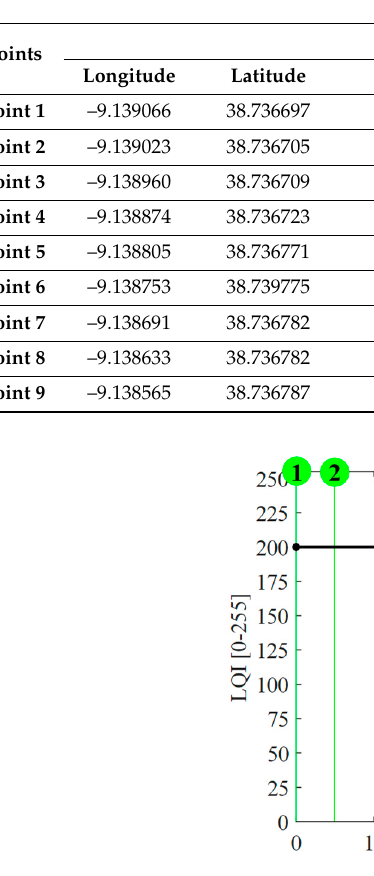
Table 2. Results achieved in test 5.3.